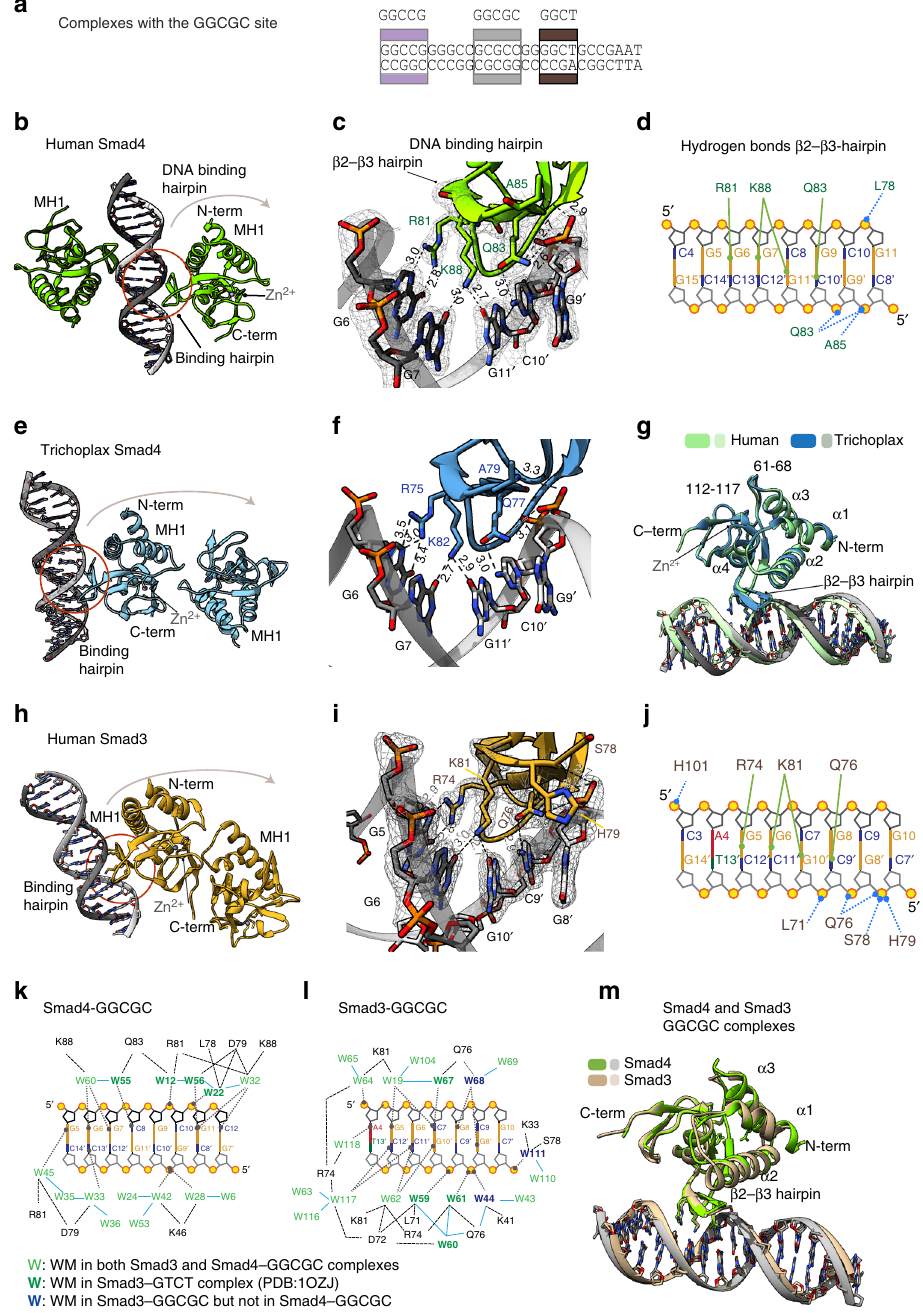
NATURE COMMUNICATIONS | 8: 2070 | DOI: 10.1038/s41467-017-02054-6 |